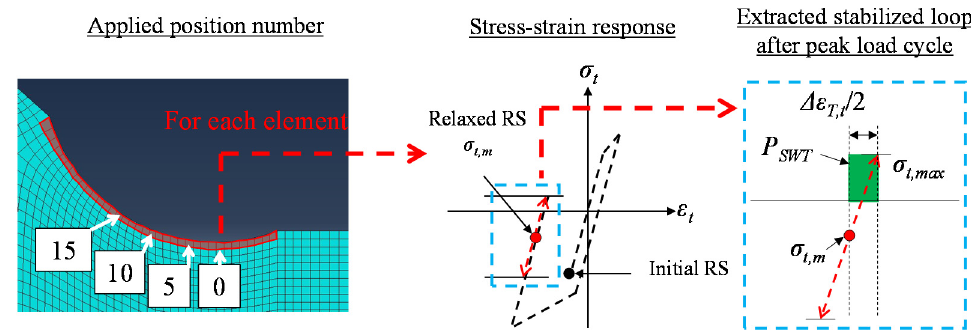
Figure 15. Positions subjected to SWT damage parameter.